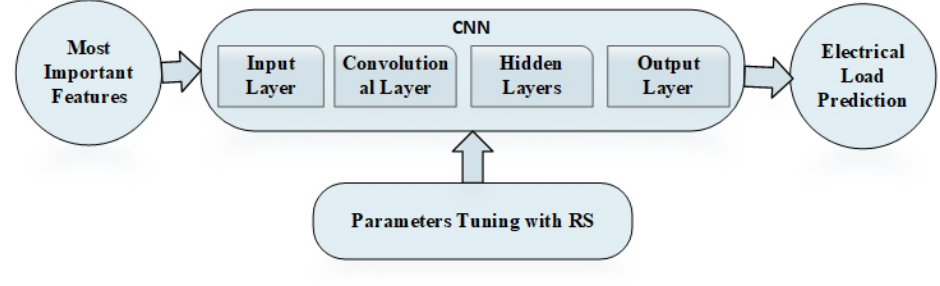
Figure 4. System model of proposed enhanced convolutional neural network